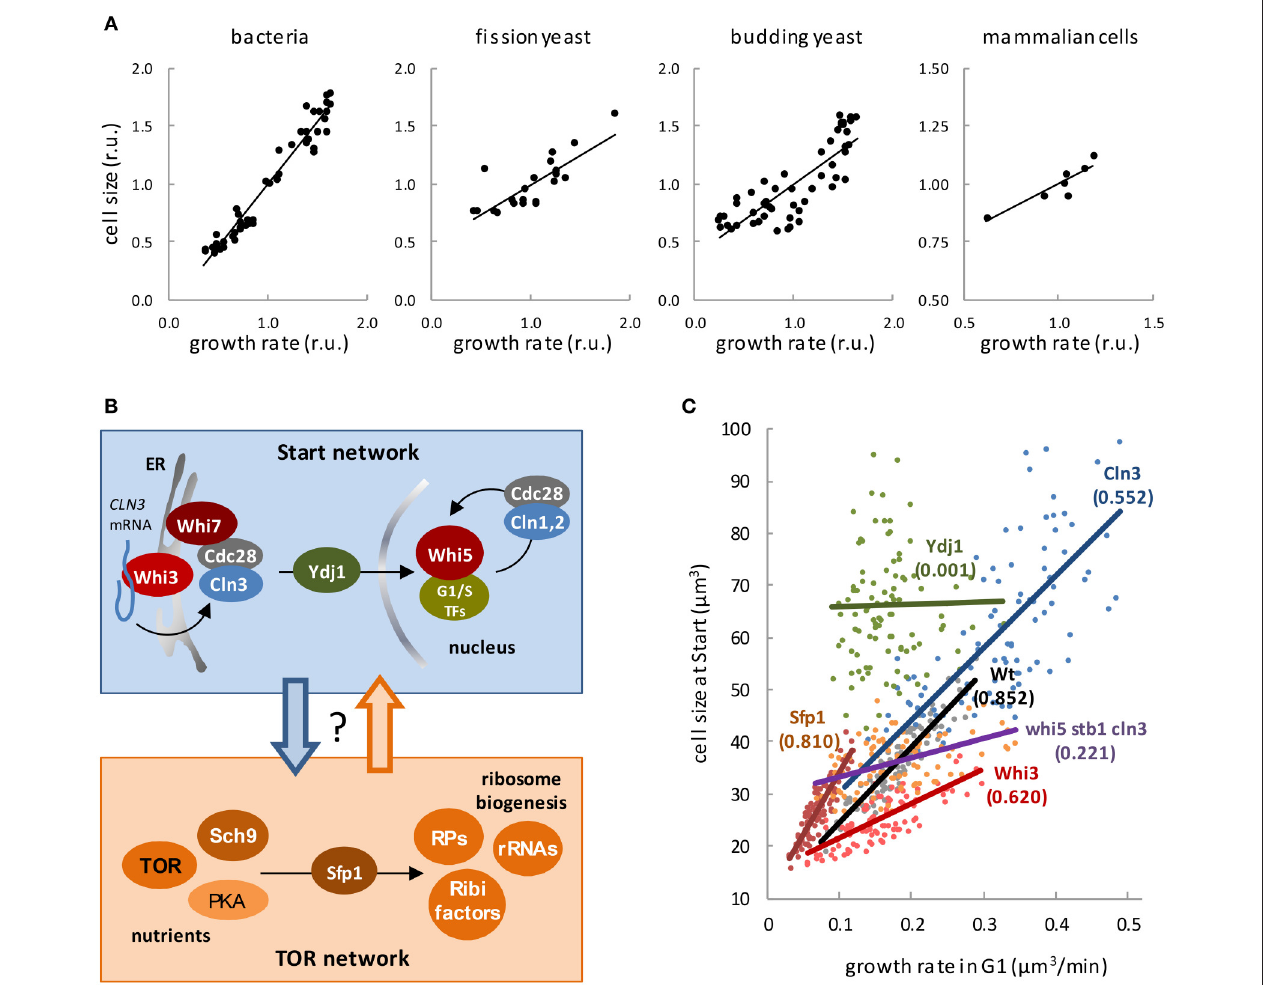
FIGURE 1 | Regulation of cell size by growth. (A) Cell size as a function of growth rate in bacterial (Schaechter et al., 1958), fission yeast (Fantes and Nurse, 1977), budding yeast (Tyson et al., 1979), and mammalian (Hola and Riley, 1987) cells. (B) The Start and Tor networks in budding yeast. Top box. The most upstream activator of cell cycle entry, the G1 Cdk-cyclin complex (Cdc28-Cln3), phosphorylates Whi5 and induces the G1/S regulon. Additional cyclins Cln1,2 ensure the G1/S transition by exerting a positive feed-back loop on transcriptional activation. Whi3 recruits Cdc28 and binds the CLN3 mRNA to localize its translation and retain the Cdc28/Cln3 complex at the cytosolic face of the ER with the contribution of Whi7, thus preventing unscheduled cell cycle entry in early G1. Once cell size requirements have been met in late G1, Cln3 is released by specific chaperones as Ydj1. Bottom box. Nutrient and trophic factor signals are transmitted by different pathways to the TOR, PKA, and Sch9 kinases, which show complex reciprocal interactions. These central kinases activate ribosome biogenesis by inducing expression of ribosome biogenesis factors (Ribi), ribosomal proteins (RP) and rRNAs, which is mainly exerted through nuclear localization of transcription factor Sfp1. (C) Cell size at Start of wild-type budding yeasts cells and the indicated mutants as a function of growth rate in G1 (Ferrezuelo et al., 2012). Coefficients of correlation are indicated within